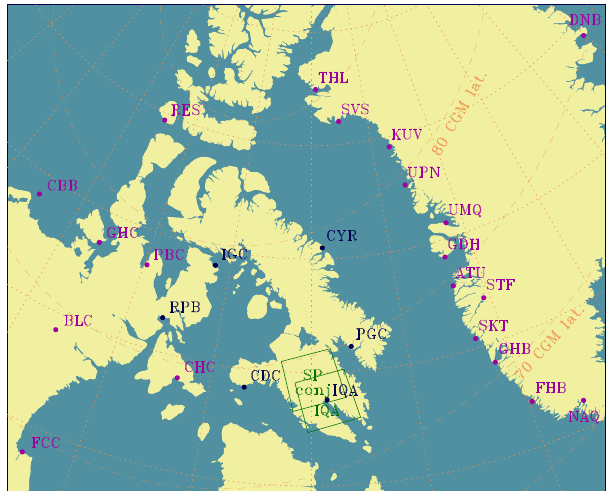
Fig. 6. Map of arctic Canada and western Greenland. Locations of magnetometer stations are indicated with filled circles, those in dark blue provided data shown in this paper, those in violet are included for completeness. Imaging riometers are indicated with outlined squares which represent their approximate field-of-view. The con- jugate position of the South Pole (SP conj) was calculated with T96, see Sect. 3.1. Dotted lines comprise a geographic grid with 5 ◦ di- visions in latitude and 10 ◦ in longitude. CGM latitude contours in dashed lines are also